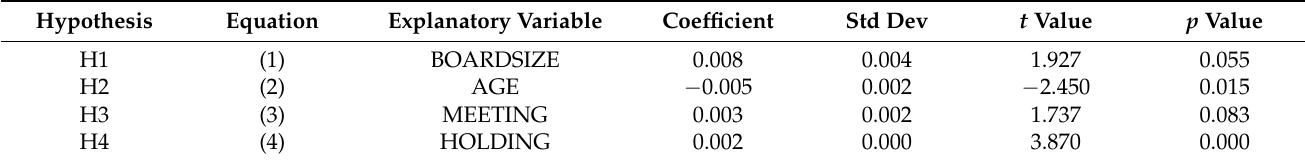
Table 3. Summary of hypothesis testing